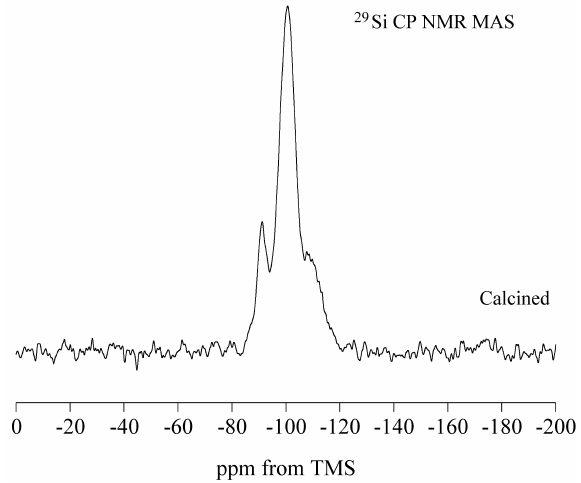
Figure 7. 1 H- 29 Si CP/MAS NMR spectrum of the AlSiMCM-41 (R/108) sample.